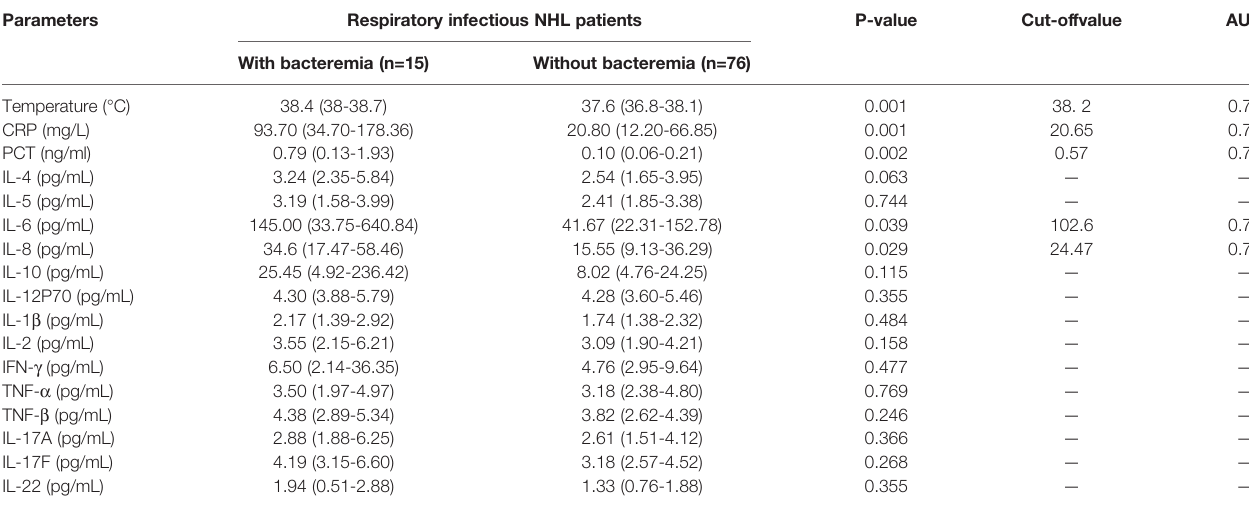
TABLE 3 | Comparison on serum CRP, PCT and cytokine levels of bacterial respiratory infectious NHL patients with or without bacteremia. Parameters Respiratory infectious NHL